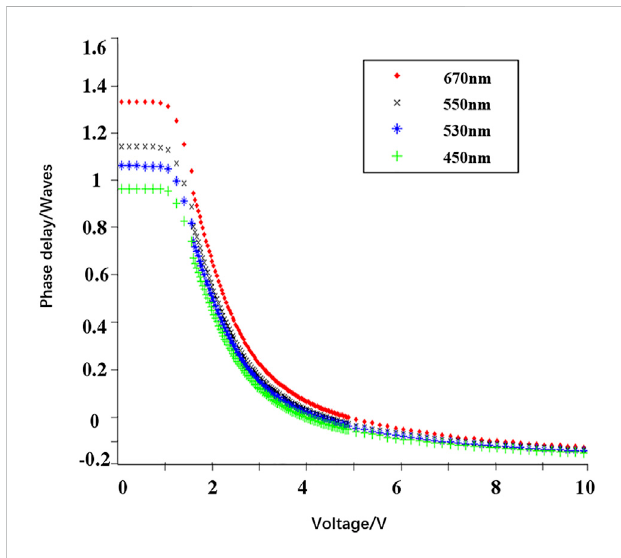
FIGURE 6 Liquid Crystal Variable Retarder phase delay characteristic curve.